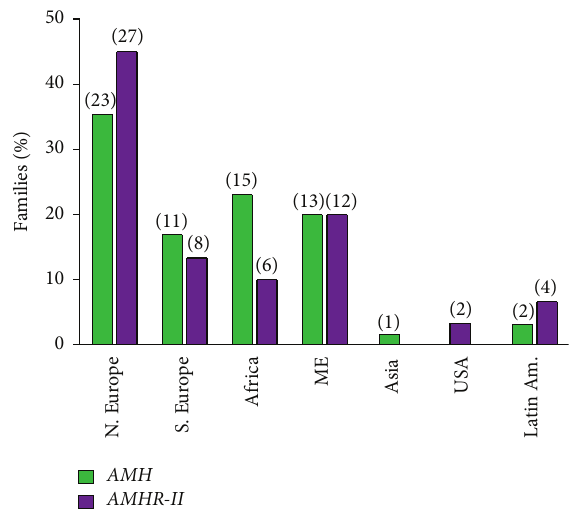
Figure 7: Ethnic origin of PMDS families. Results are expressed as percentages of total number of families with, respectively, AMH or AMHR-II mutations. The number of families is shown between parentheses. Differences between AMH and AMHR-II mutations are not statistically significant; the predominance of Northern Europe merely reflects a recruitment bias. N. Europe: Northern Europe (including Northern France), S. Europe: Southern Europe (includingSouthernFrance),Africa:(mostlyMaghreb),ME:Middle East (includes Turkey, Afghanistan, and Pakistan, as per Wikipedia definition), Latin Am.: Latin America (includes Mexico, Central and South America).